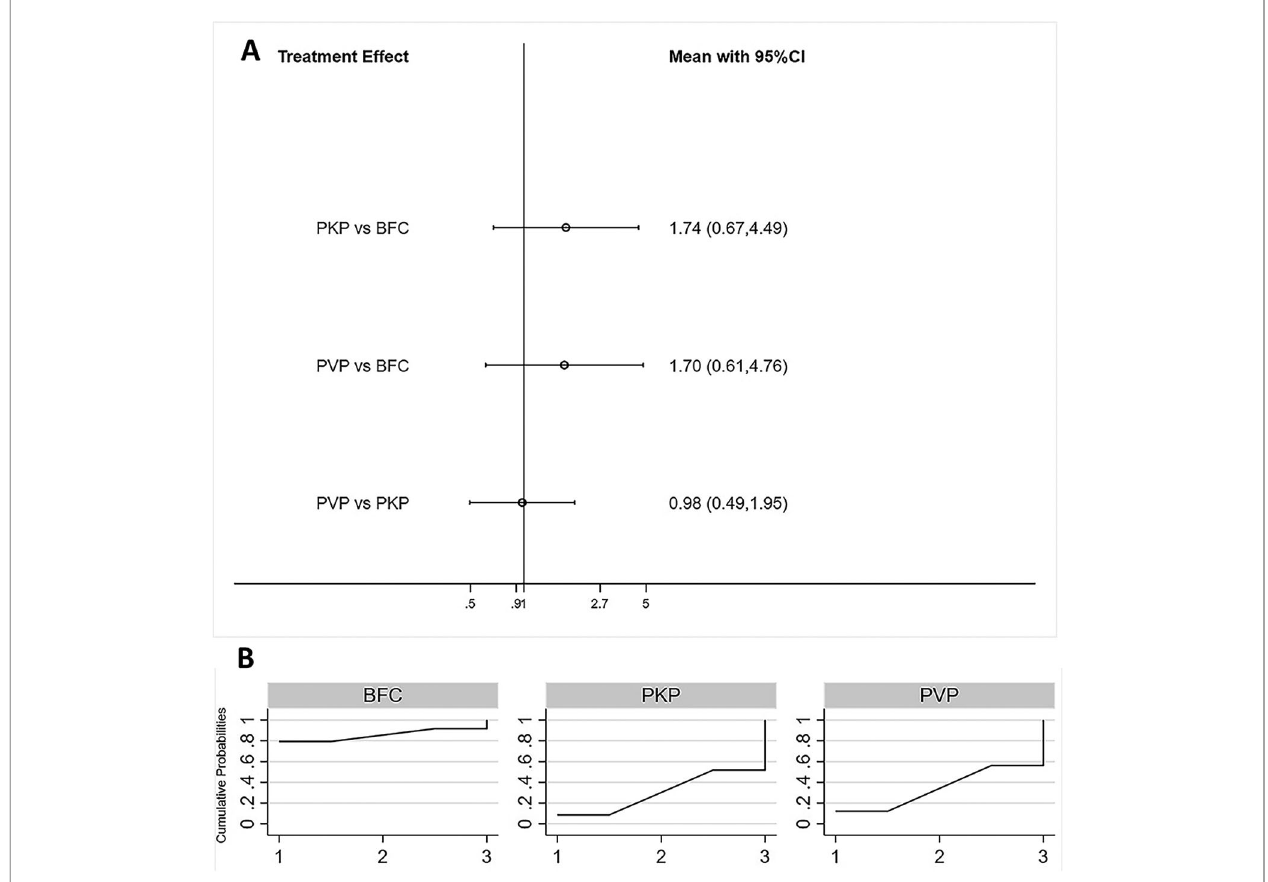
FIGURE 6 | Forest plot of adjacent segments re-fracture ( A ) and relevant SUCRA of each procedure ( B ). PVP, percutaneous vertebroplasty; PKP, Percutaneous kyphoplasty; BFC, bone- fi lling mesh